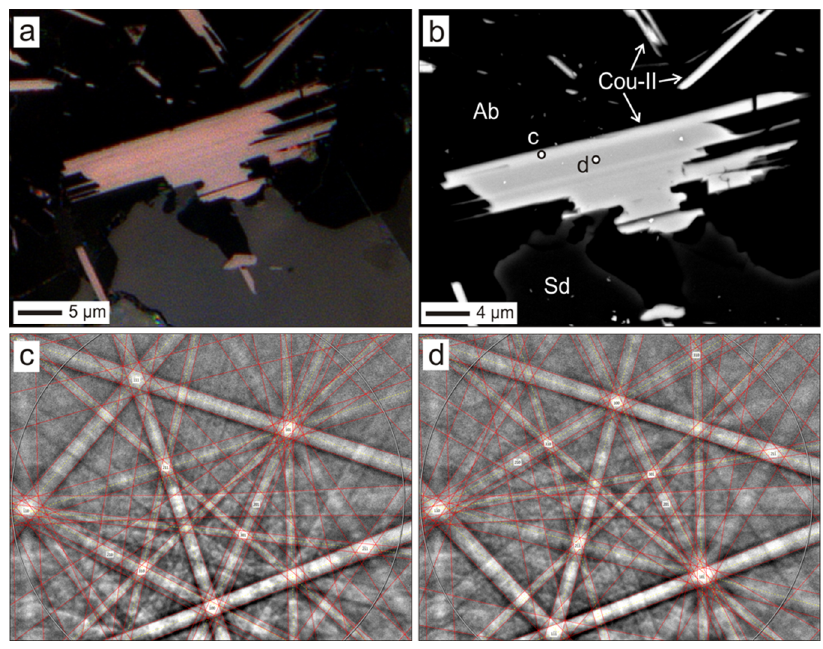
Figure 5. Coulsonite-II (Cou-II) with a di ff erent TiO 2 content: ( a )—reflected light images; ( b )—BSE image; ( c , d )—EBSD image for Cou-II. Ab—albite.